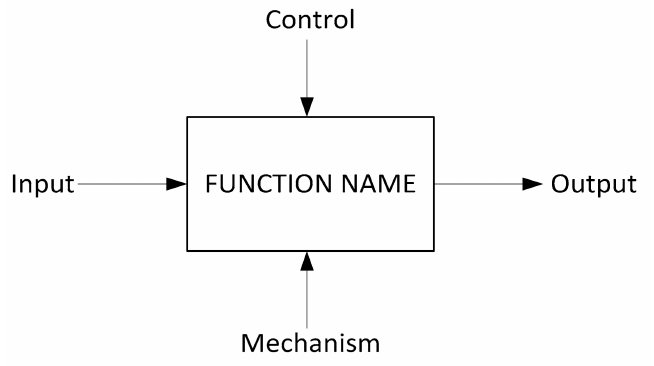
Figure 1. The basic diagram of the Integration Definition for Function Modeling methodology (IDEF0). A function is manufactured with the use of ICOMs: Inputs, Controls, Outputs and Mechanisms